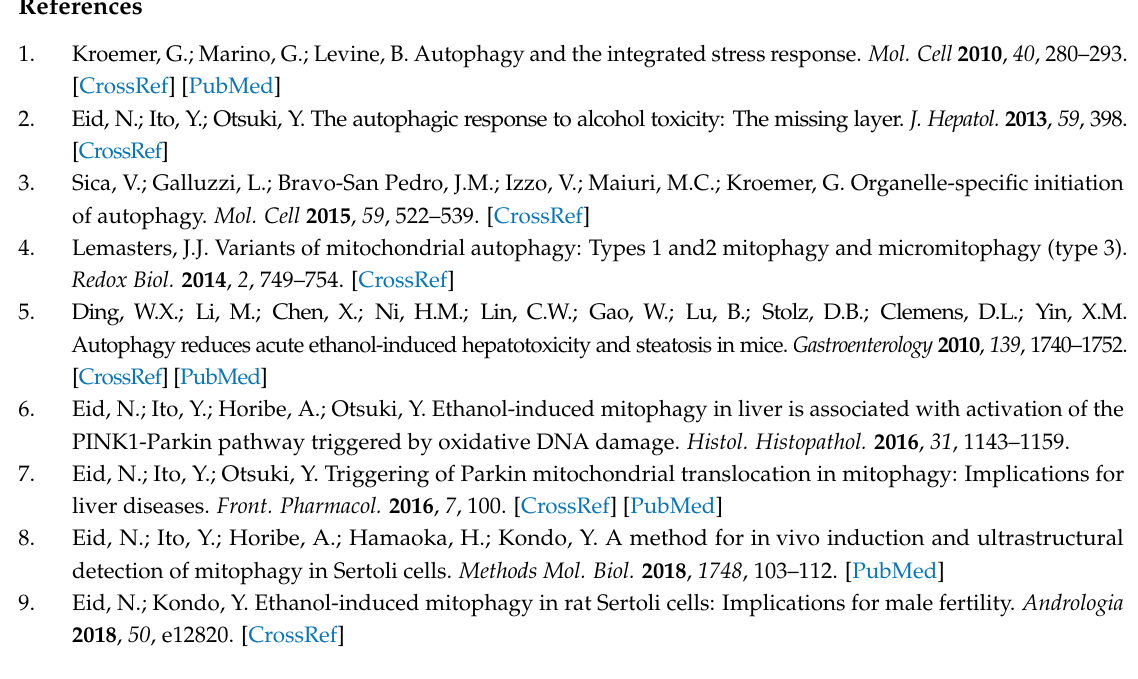
Figure S1: Low-power micrograph showing perinuclear accumulation of damaged mitochondria (broken arrows) and mitophagic vacuoles (arrows) in SC of ETRs. S: SC nucleus; LD: lipid droplet. Figure S2: TUNEL positive germ cells (green labeling) of ETRs with non-apoptotic. Arrows mark SCs nuclei. Figure S3: Enhanced LC3 (red) and p62 (green) colocalization in SCs of ETRs. The white arrows indicated colocalization signals upon merging (yellow-orange). Figure S4: Overexpression of PINK1 in ETR SCs. Arrows indicate SCs nuclei. Figure S5: IF double labeling of LC3 (red) and Pan cathepsin (green) in ETRs. Arrows mark enhanced colocalization signals (yellow-orange) in SCs. S, SC